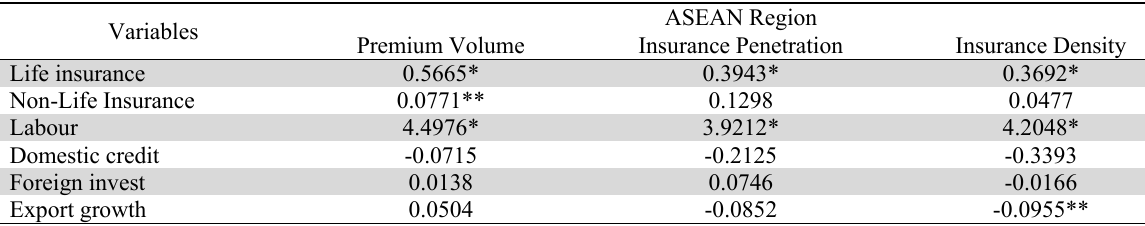
The Coefficient of Fixed Effect